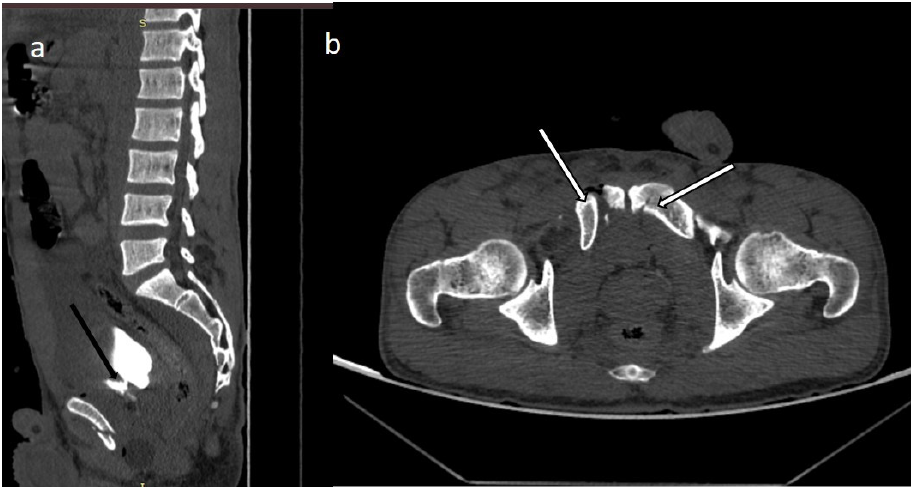
Figure 4 . (a) A 40-year-old male patient with delayed contrast images showing rent in bladder neck and extraperitoneal contrast extravasation (black arrow). (b) Multiple pelvic fractures are seen involving inferior pubic rami and acetabulum (white